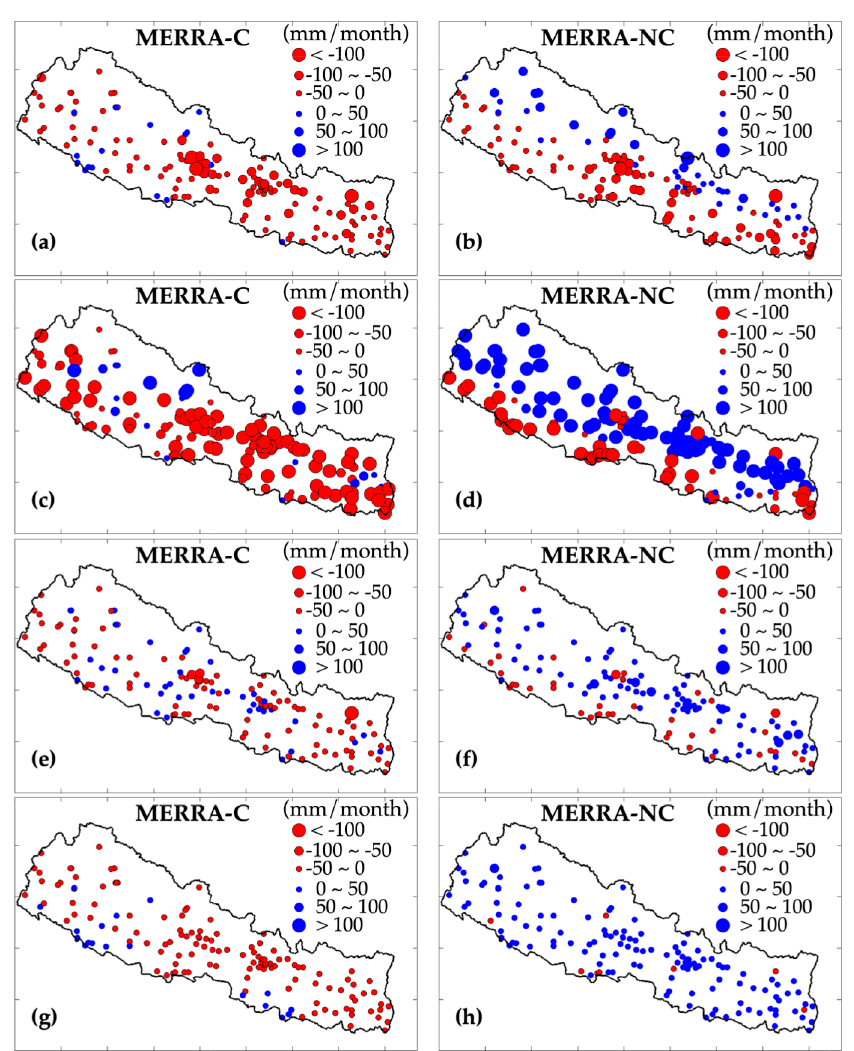
Figure 6. Spatial distribution of mean bias (MB) at each station in MERRA-C and MERRA-NC for a different season, ( a , b ) pre-monsoon, ( c , d ) summer monsoon, ( e , f ) post-monsoon, and ( g , h ) winter, respectively. Red and blue circles represent the underestimated and overestimated of precipitation amount across the country, respectively.